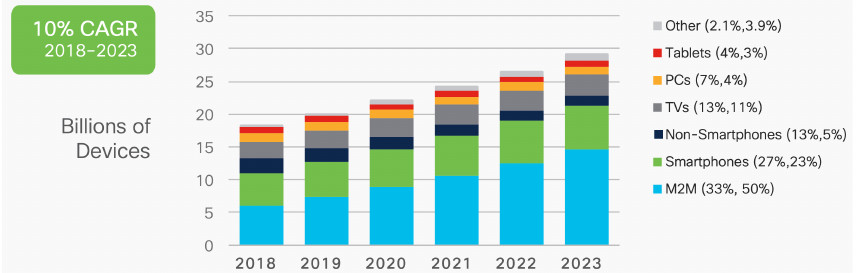
Figure 1. Growth of global devices and